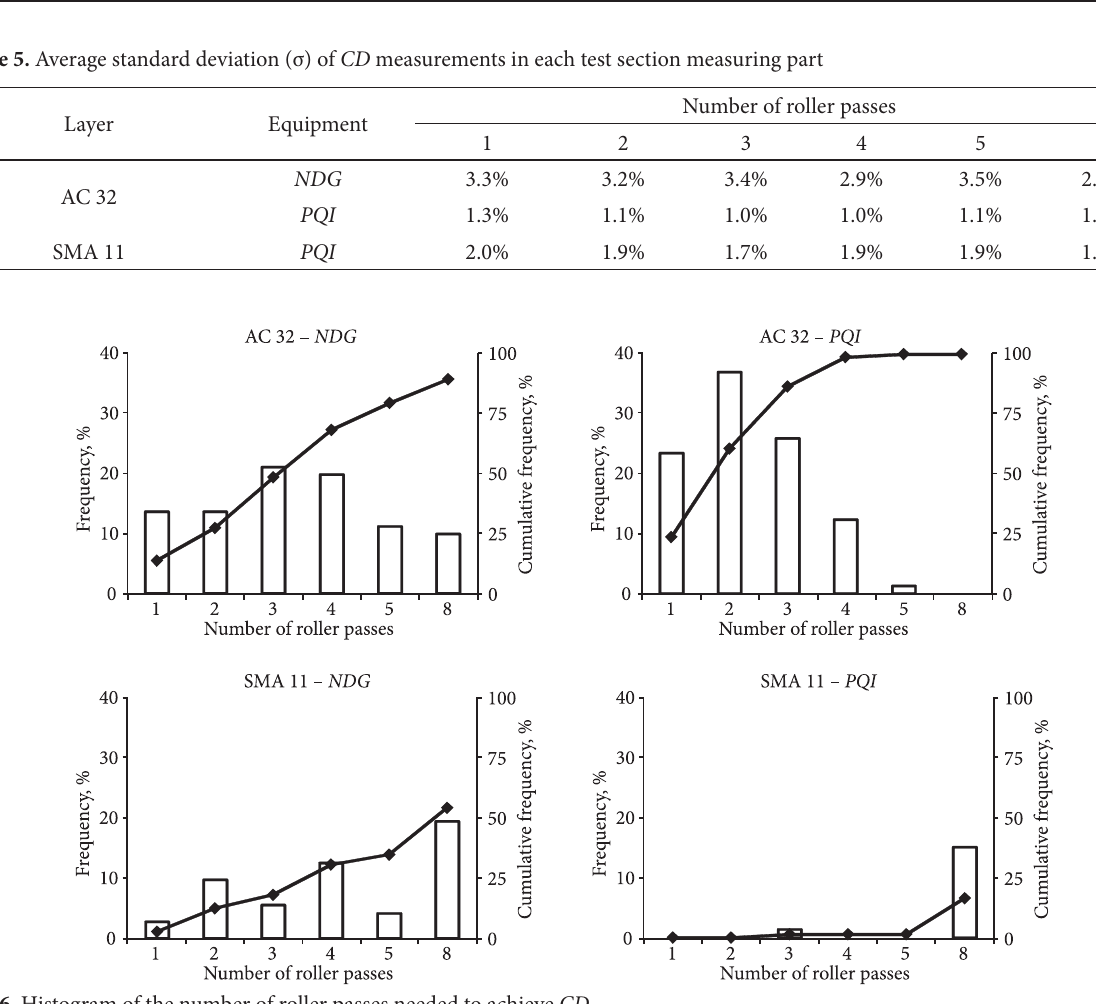
fig. 6. Histogram of the number of roller passes needed to achieve CD